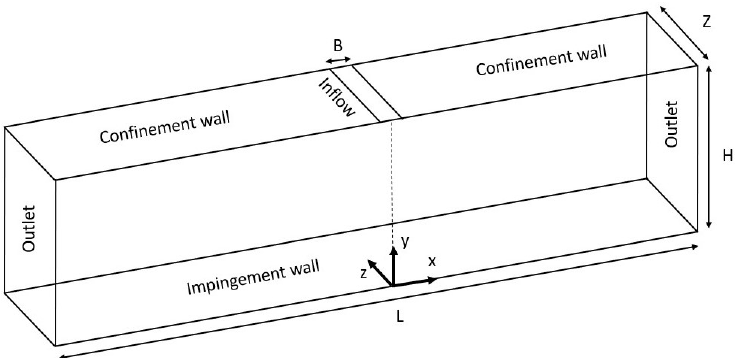
Figure 2. Schematic of the computational domain and boundary conditions used in unsteady laminar and LES